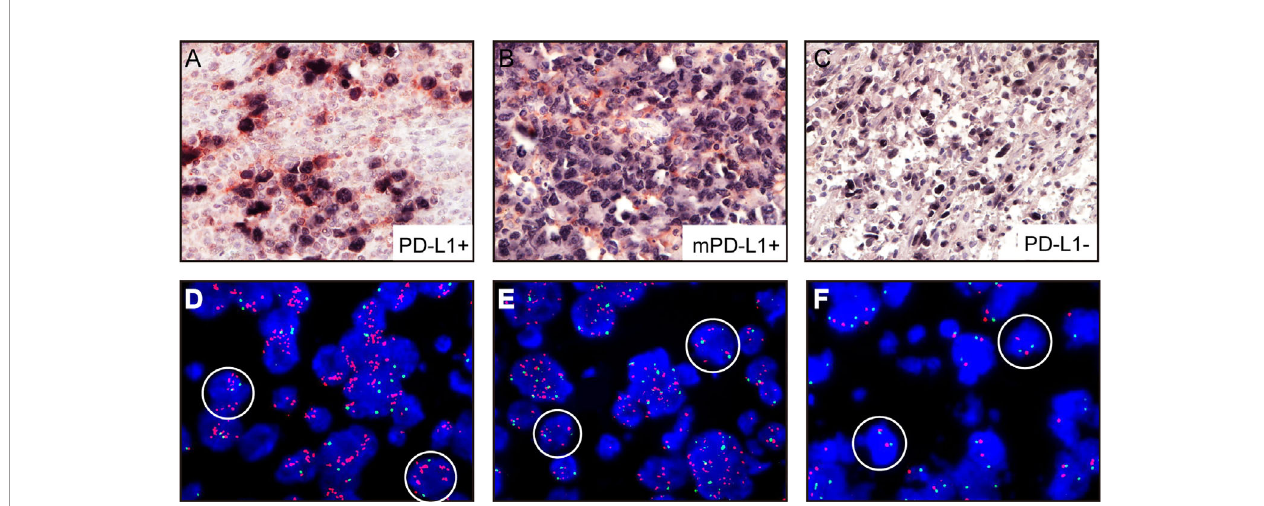
FIGURE 1 | Representative immunohistochemical analysis of PD-L1 and PD-L1 FISH in A-DLBCL (400×magni fi cation). (A) PD-L1 + A-DLBCL, tumor cells were double positive for PD-L1 (red) and PAX5 (black); (B) mPD-L1 + DLBCL, tumor cells were positive for PAX5 and negative for PD-L1; (C) PD-L1- A-DLBCL, tumor cells were negative for PD-L1 (red) and positive for PAX5 (black); (D) Copy number gains in PD-L1 locus; (E) Ampli fi cation in PD-L1 locus; (F) Normal PD-L1 FISH